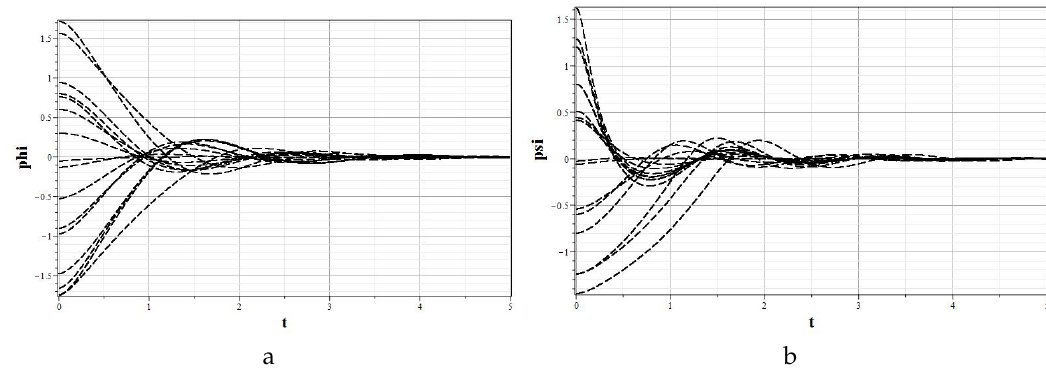
Figure 2. Dependence of the fields φ ( a ) and ψ ( b ) on t for the potential (45).